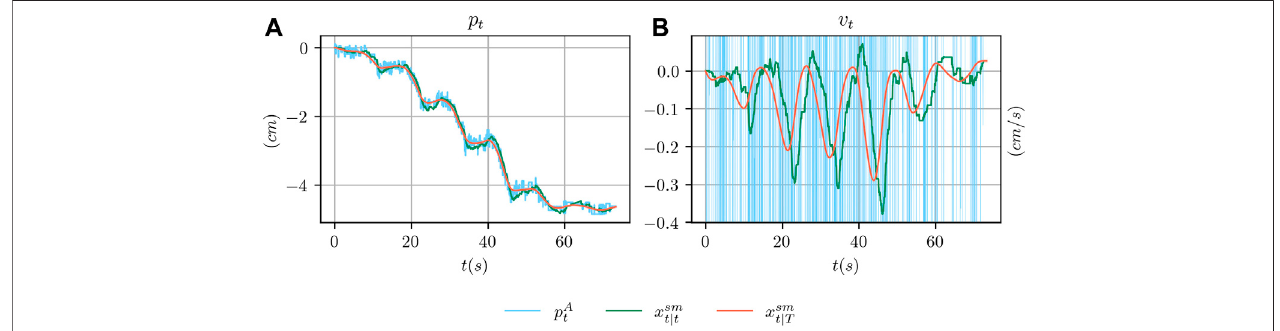
FIGURE5| In (A) ,comparisonbetweenthegroundtruthpositionfromtheArUcomarkerdetectionsystem p A t ,its fi lteredversion p sm t | t anditssmoothedversion p sm t | T obtained using a Kalman fi lter and smoother respectively. In (B) , comparison between the ArUco velocity signal obtained using fi nite differences, fi ltered and smoothed